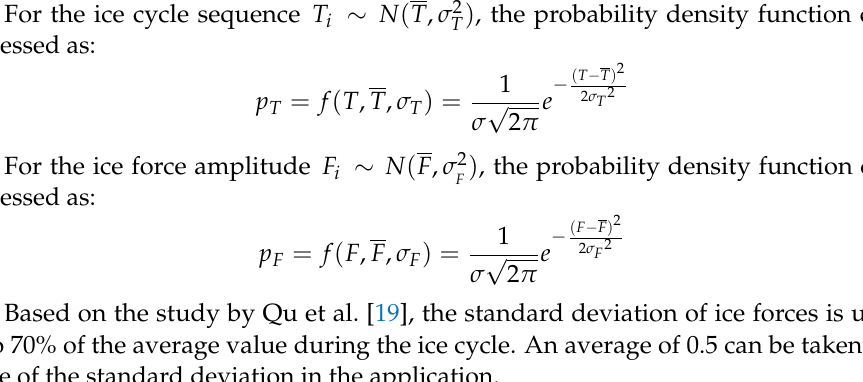
Figure 9. Normal distribution characteristics of flat-ice force amplitudes.